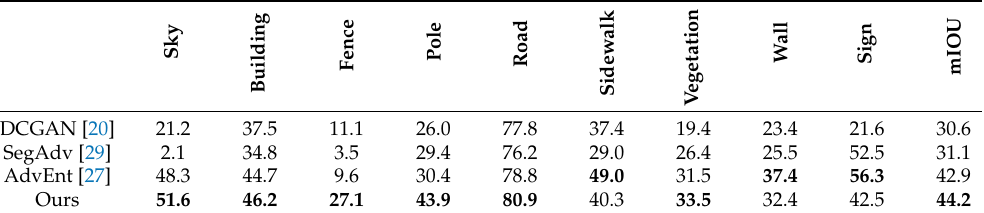
Table 4. Semantic segmentation restoration performance mIOU of unsupervised learning on MICC- SRI